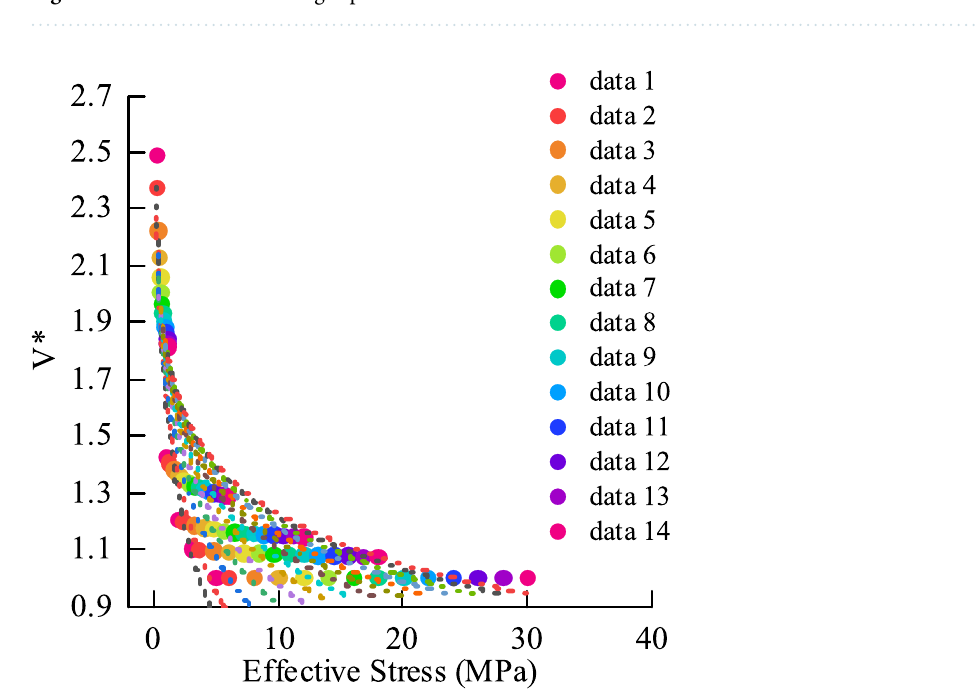
Figure 10. Results of Unloading experiments.